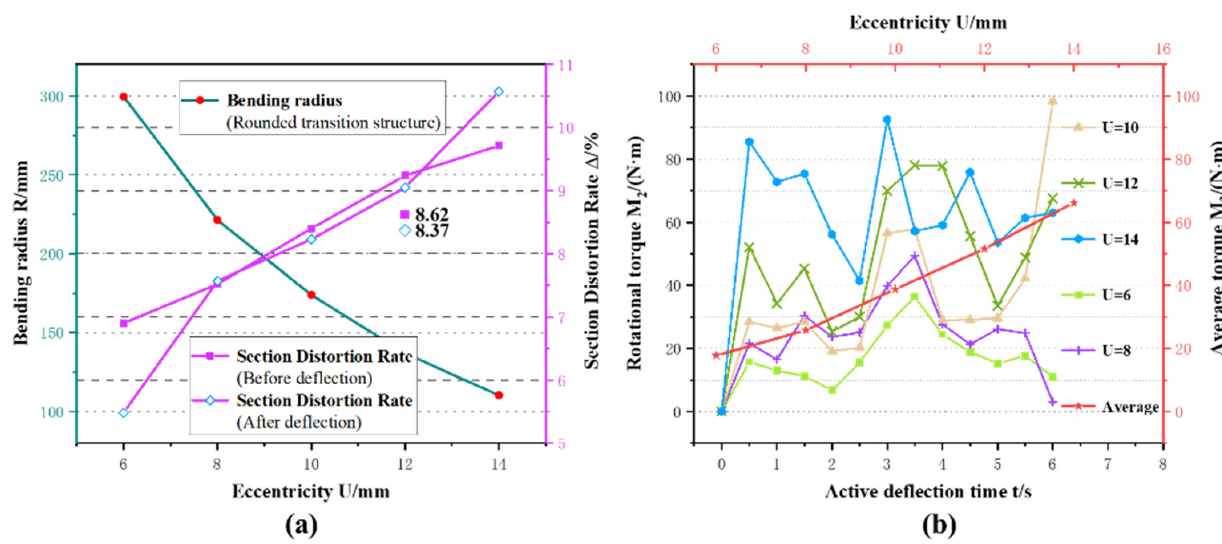
Figure 11. Simulation experimental results of active deflection: ( a ) deflection angle and section dis- tortion distribution under different eccentricities; ( b ) rotational torque distribution during deflec- tion.